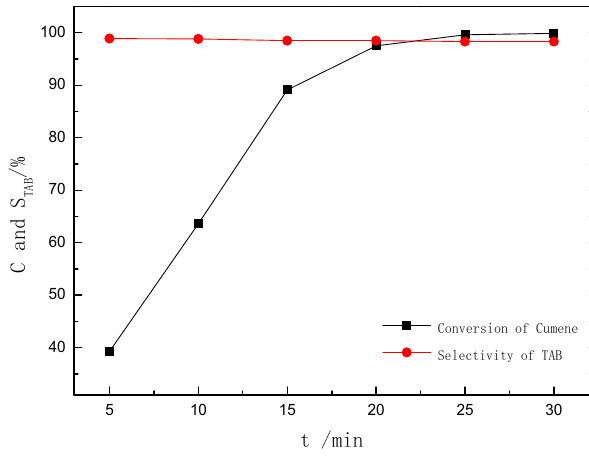
Figure 7: The e ff ect of reaction time on the conversion of cumene and selectivity toward TAB.